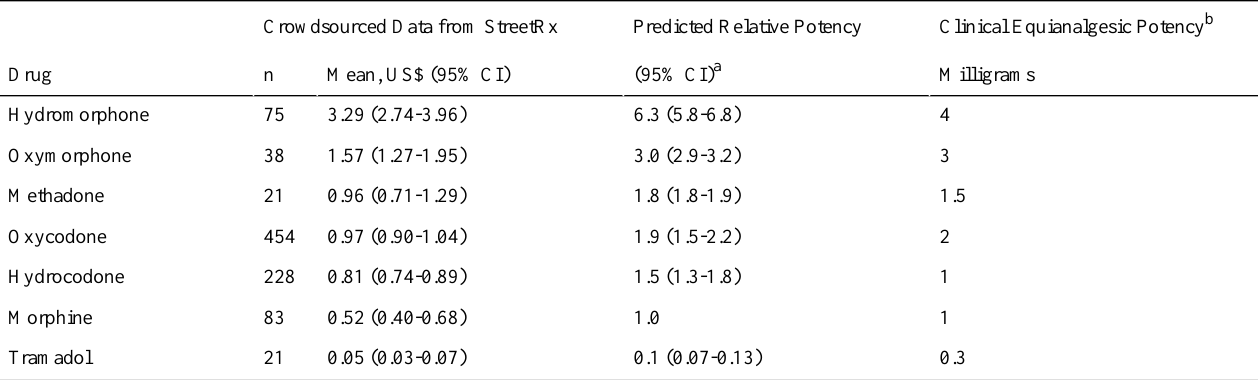
a Morphine values differ between Drug Diversion Survey and Silk Road based on statistical test for possibility of random error ( P <.05), but not between StreetRx and the other data sources. Table 2. Mean street prices from crowdsourced data, adjusted for potency relative to morphine, United States, 2012.